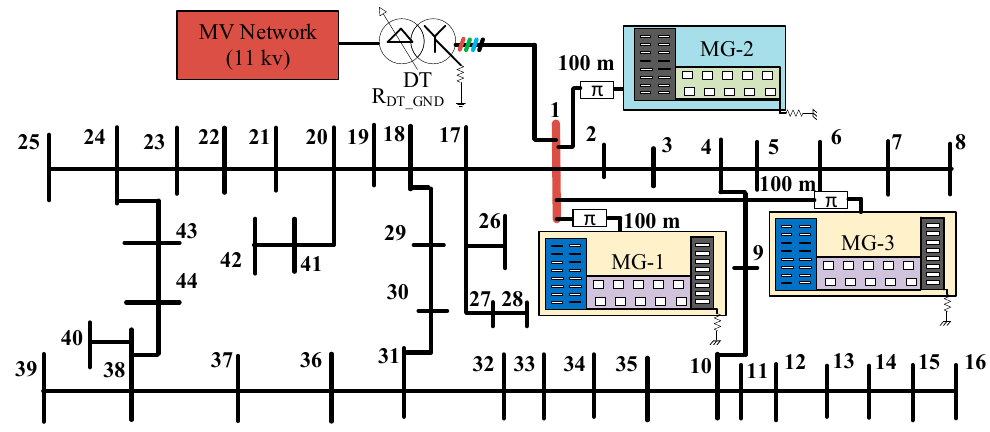
Figure 11. 3-phase 4-wire 44-bus Low Voltage (LV) network including MMG system.